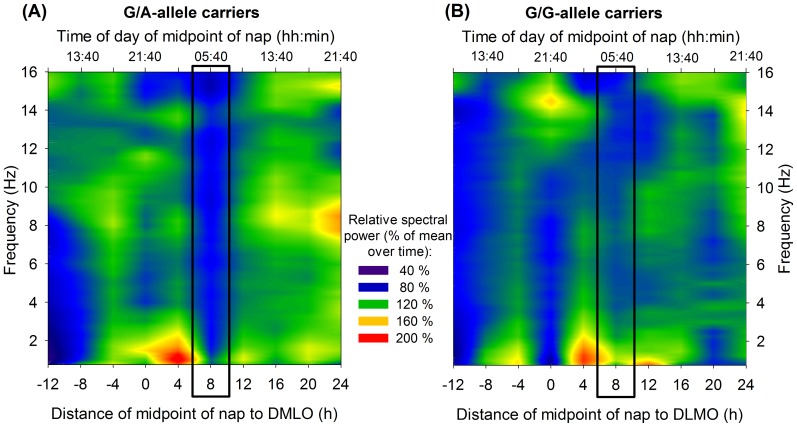
Relative EEG power density per genotype.Relative EEG power density is depicted as deviation from mean over time (i.e., over all naps) per genotype. Blue colours mirror relative decreases in EEG power density compared to the mean over time; green, yellow and red colours indicate relative increases of EEG power density compared to the mean over time. During the early morning hours (i.e., during the nap scheduled to 5:20–6:00 a.m.), highlighted by black boxes, G/A-allele carriers showed a relative decrease specifically in the range of 8–16 Hz (A), which was not present in G/G-allele carriers (B).